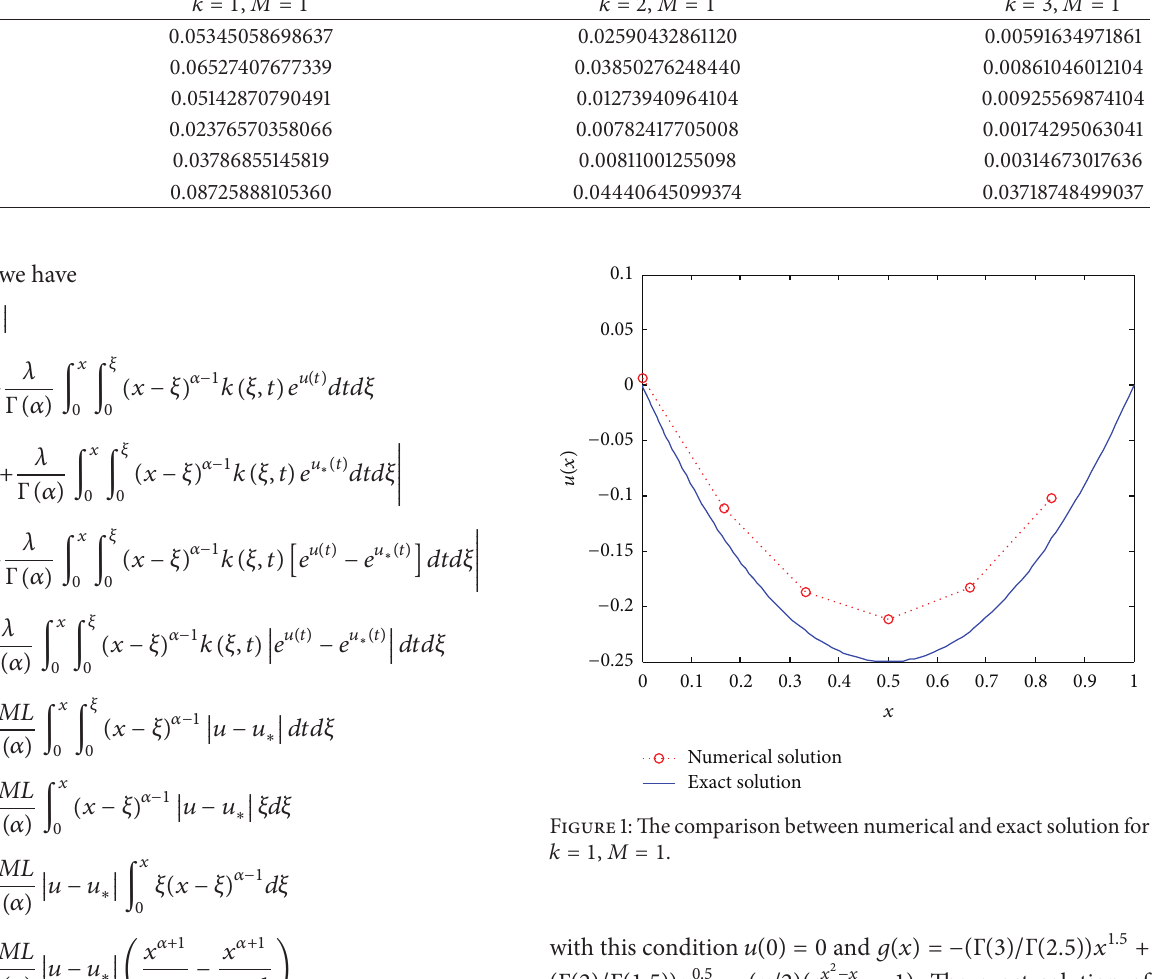
with this condition 𝑢(0) = 0 and 𝑔(𝑥) = −(Γ(3)/Γ(2.5))𝑥 1.5 + (Γ(2)/Γ(1.5))𝑥 0.5 − (𝑥/2)(𝑒 𝑥 2 −𝑥 − 1) . The exact solution of this problem is 𝑢(𝑥) = 𝑥 2 − 𝑥 . Table 1 shows the absolute errors of the approximate solutions and the exact